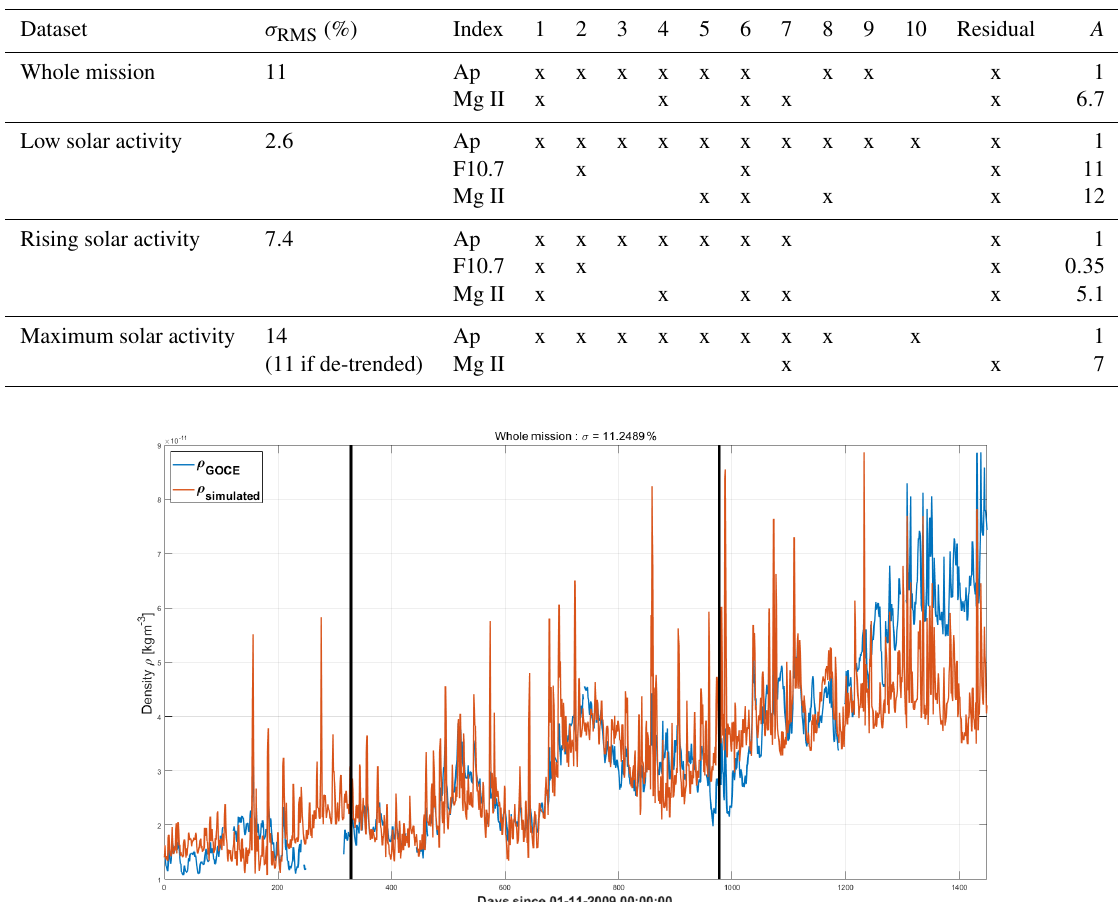
Figure 10. Thermospheric density synthesized (red line) from the optimal combination of Ap, Mg II and F10.7. Whole mission. Blue line shows thermospheric-density data. The rising trend in density in the last third of the mission is due to orbit lowering and is therefore not shown in the reconstructed signal.